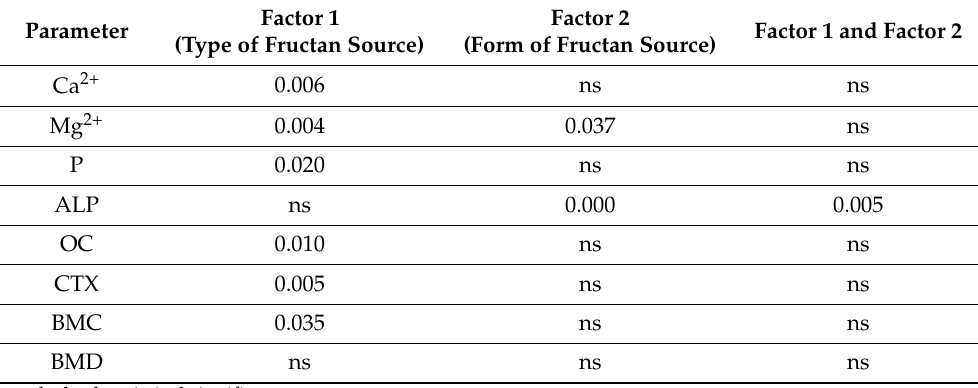
Table 4. The results of two-way analysis of variance ( p -values).